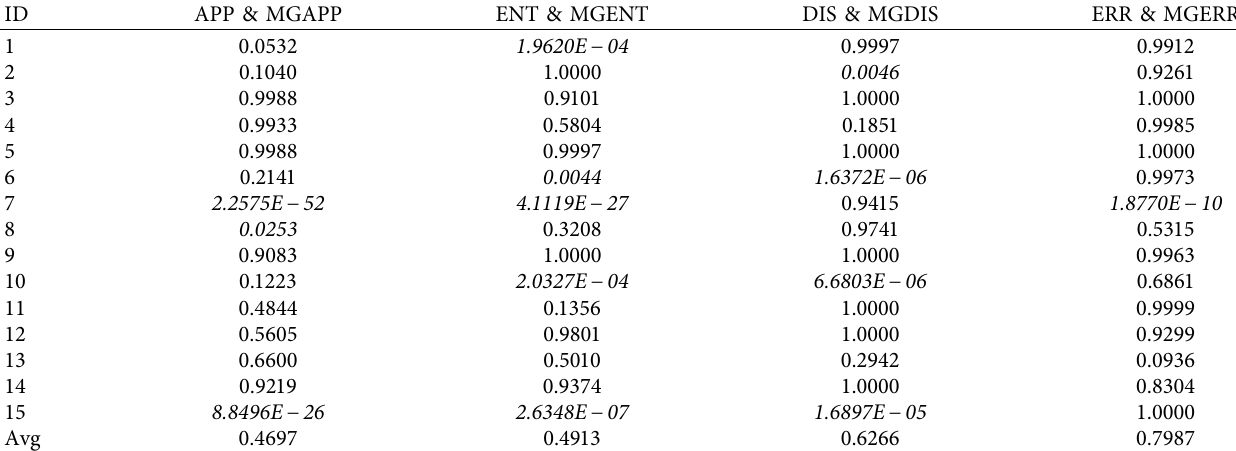
Table 10: Comparisons of the distributions with using CART (the values less than 0.05 are